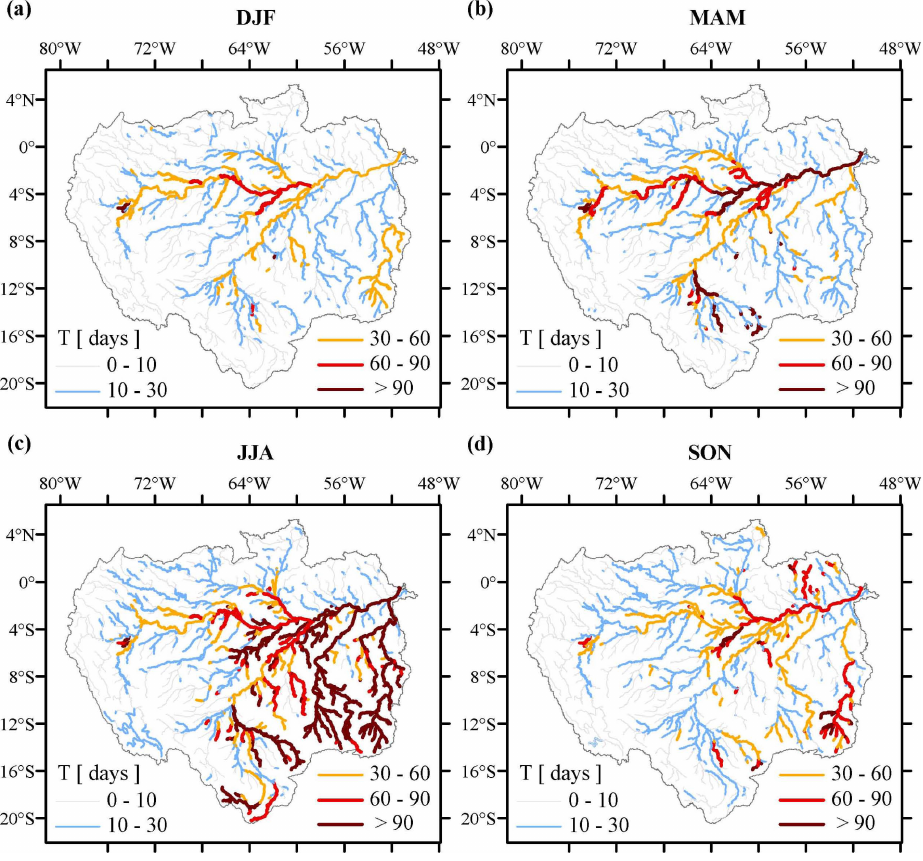
Fig. 5. Spatial distribution of T values considering (a) DJF, (b) MAM, (c) JJA and (d) SON time periods. Results are shown only in rivers reaches with upstream drainage area larger than 3000km 2